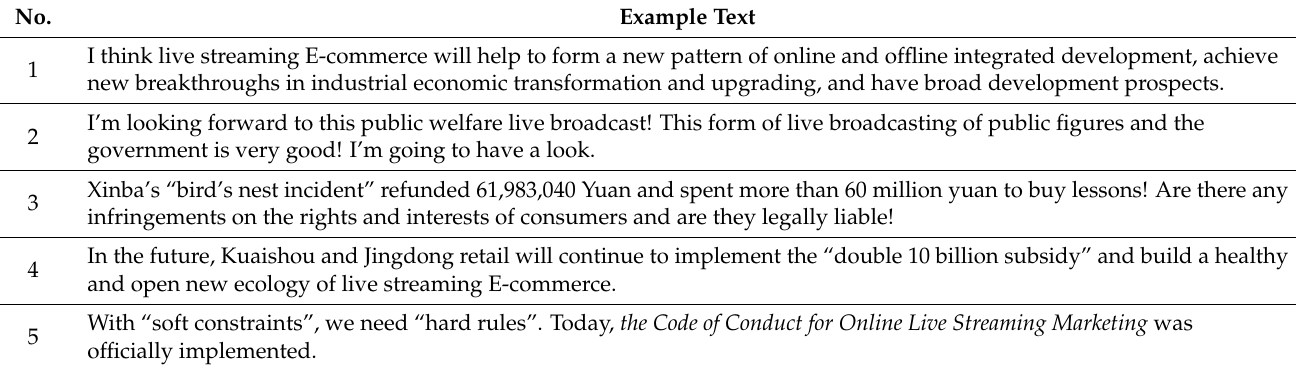
Table 8. Example text under the LDA sequence topic after policy